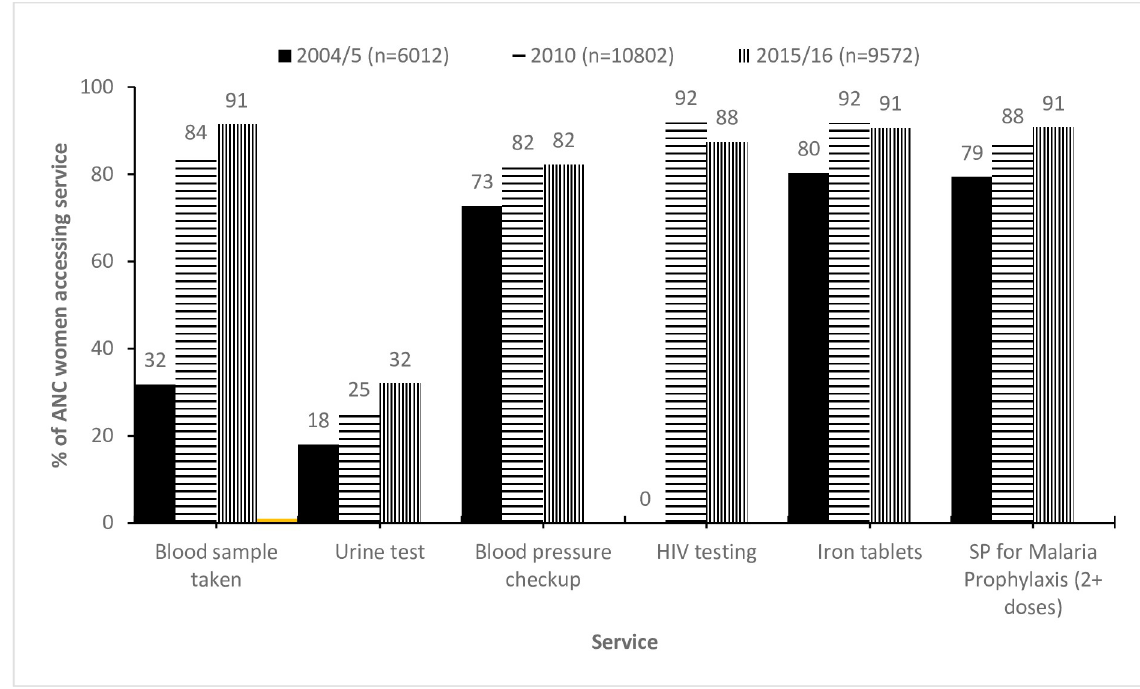
Fig 1. Services received by women that attended antenatal care in Malawi between 2004 and 2016. SP = Sulfadoxine-Pyrimethamine, % = weighted